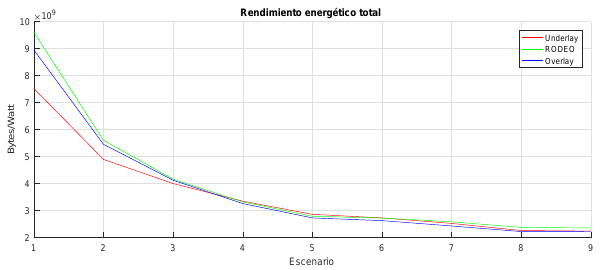
Figure 7. Average total performance depending on the